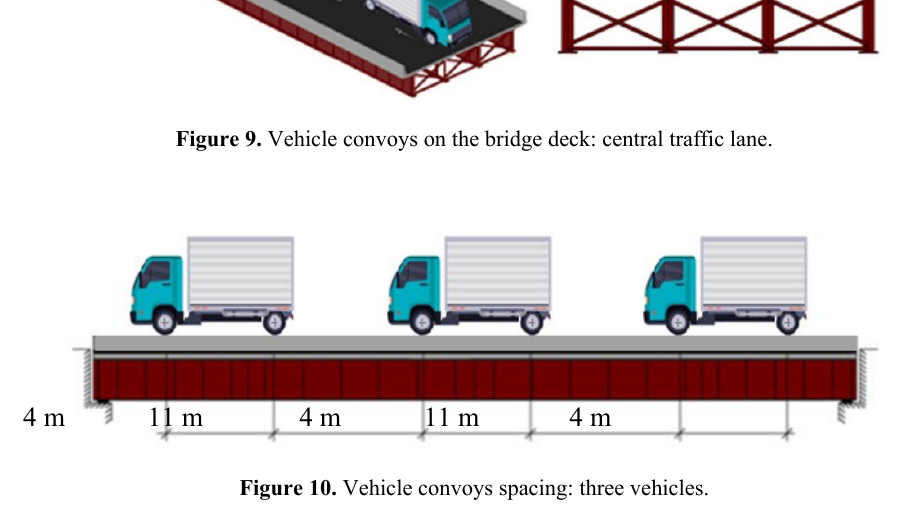
Figure 10. Vehicle convoys spacing: three